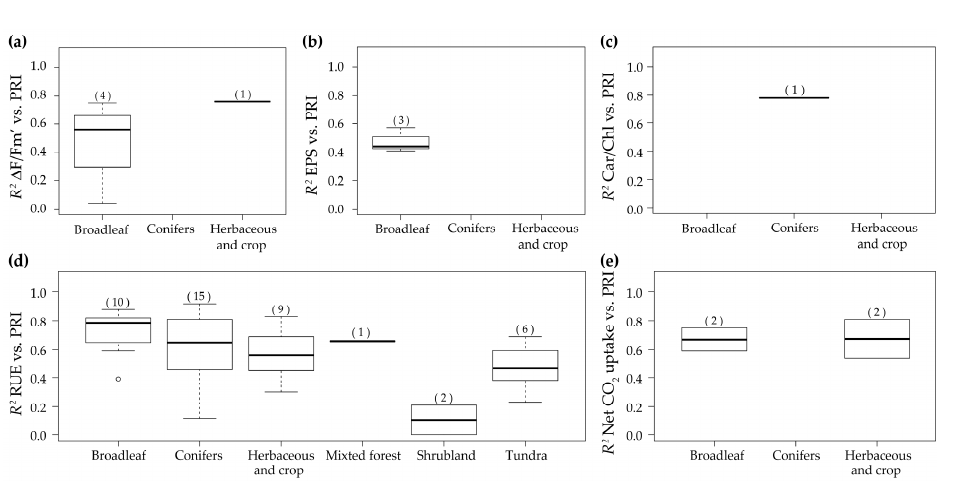
Figure 6. The mean values of coefficients of determination of the relationships between PRI and several physiological variables at the canopy level and short daily timescale. All the correlations were significant ( p < 0.05) except for one relationship between PRI and carotenoid in Pinus sylvestris [117] and one between PRI and steady-state chlorophyll fluorescence (Ft) [73]. Error bars indicate standard error.